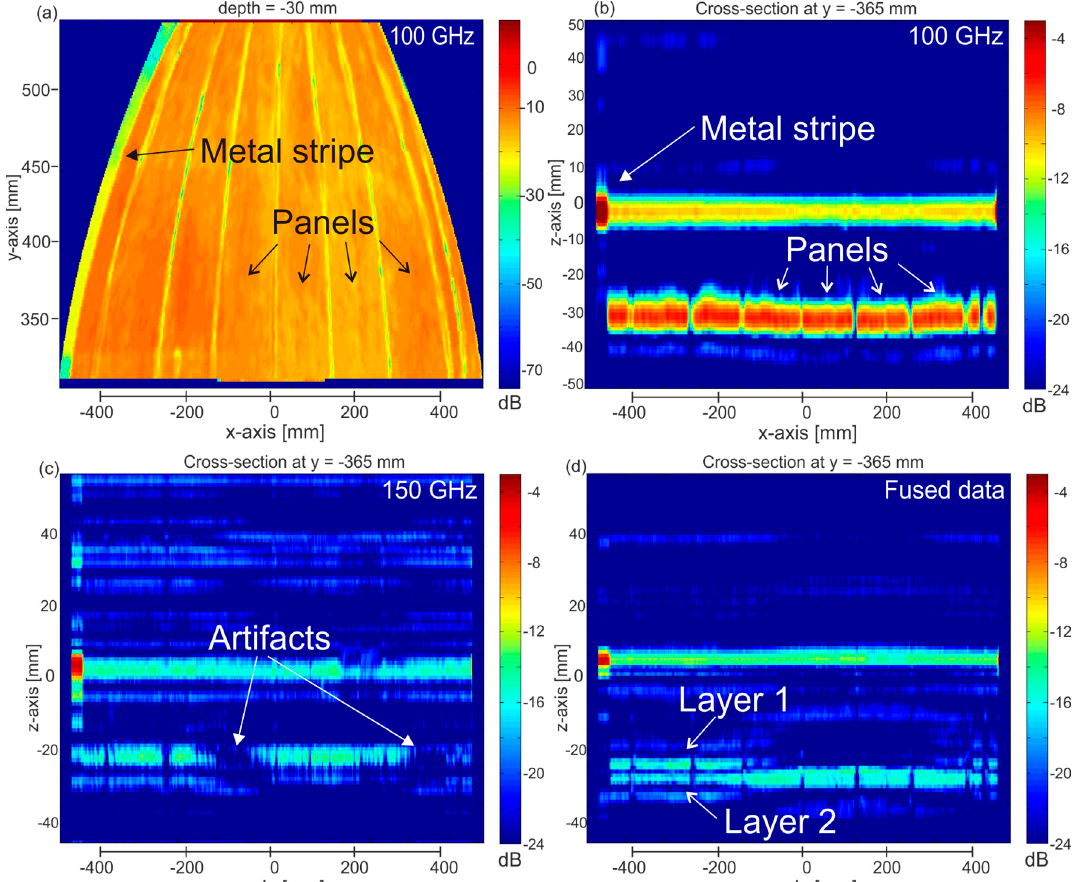
Figure 9. Top: Reconstructed image of the radome measured with the 100 GHz unit showing the radome’s back surface ( a ) and a depth cross section ( b ). The GFRP panels, which the radome is composed of, are clearly identified in both images, as well as the attached metal stripe (left edge). Bottom: The same cross-sectional view from the reconstructed measurement with the 150 GHz unit ( c ) exhibits a significantly smaller penetration depth. Fusion of the data of both units ( d ) can be employed to achieve an improved depth resolution and reveals delamination of the GFRP panels from the carbon mandrel at the back surface (Layers 1 and 2).